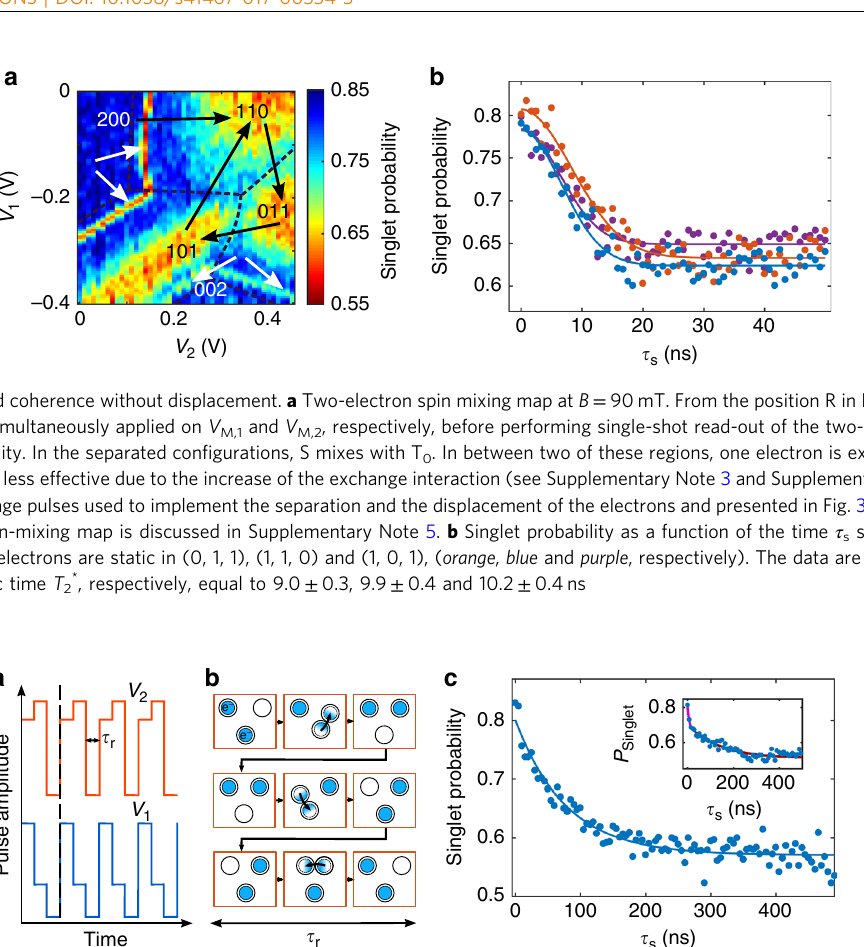
interaction between the two electrons can be neglected and the system is dominated by the coupling to the nuclear spins of the heterostructure via hyper fi ne interaction 16, 23, 26 . At a magnetic fi eld of 150 mT, the spin mixing occurs only between S and T (see Fig. 2b). By varying τ s , we observe a Gaussian decay e (cid:1) τ s2 = T (cid:3) 2 2 of the singlet probability characterized by a timescale Τ 2 * close to 10 ns, very similar in each mixing region 16, 23 . In addition to the S-T 0 mixing regions, we notice four additional mixing lines, clearly separated from the other mixing regions. We attribute them to the mixing of S and T + states and their observation is a signature of large and coherent tunnel-coupling between the dots (see Supplementary Note 3) 23 .